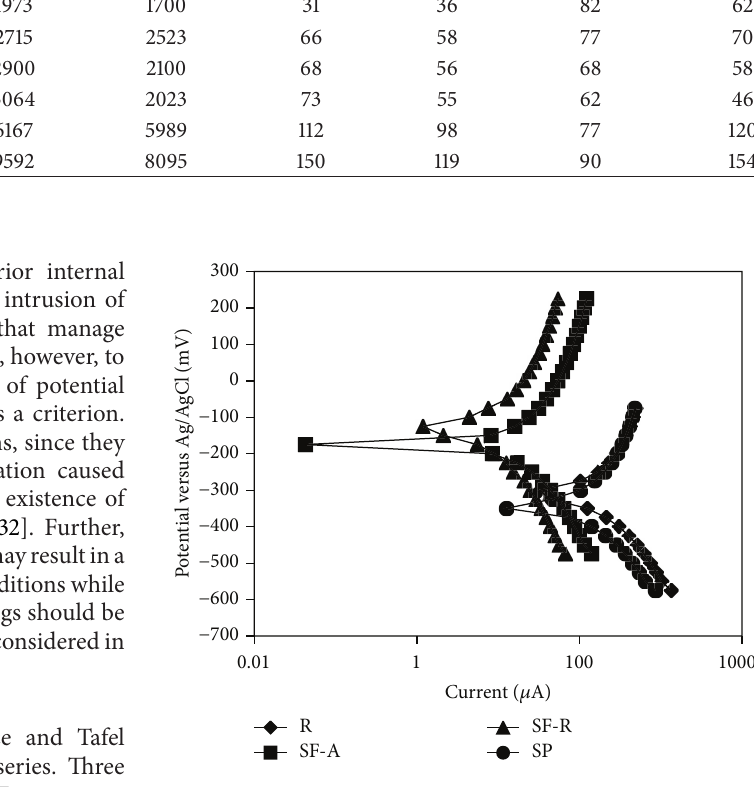
Examination of the Tafel plots and data in Figure 6 for steel in SF-R concrete indicated that at the end of the testing period the corrosion currents are 63 and 16 fold lower than those for steel in R, and SP concretes respectively. The corresponding values for steel in SF-A concrete are 17 and 4 fold lower. Superior corrosion resistance performance of steel in SF-R concrete over the R as well as SP concrete